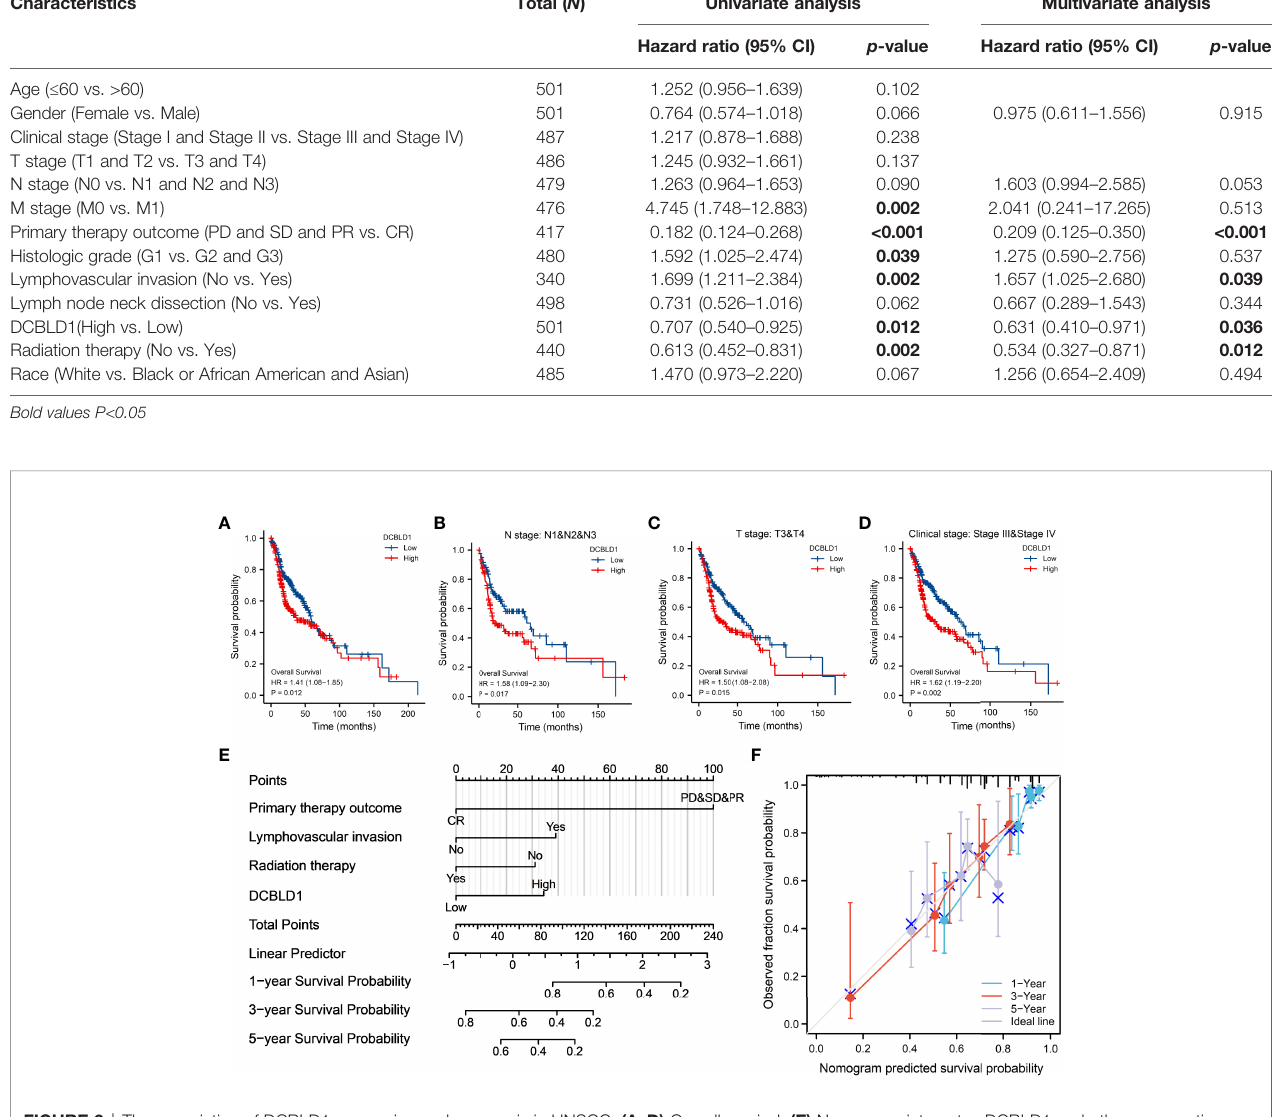
FIGURE 3 | The association of DCBLD1 expression and prognosis in HNSCC. (A – D) Overall survival. (E) Nomogram integrates DCBLD1 and other prognostic factors in HNSCC from the TCGA data. (F) The calibration plot of the